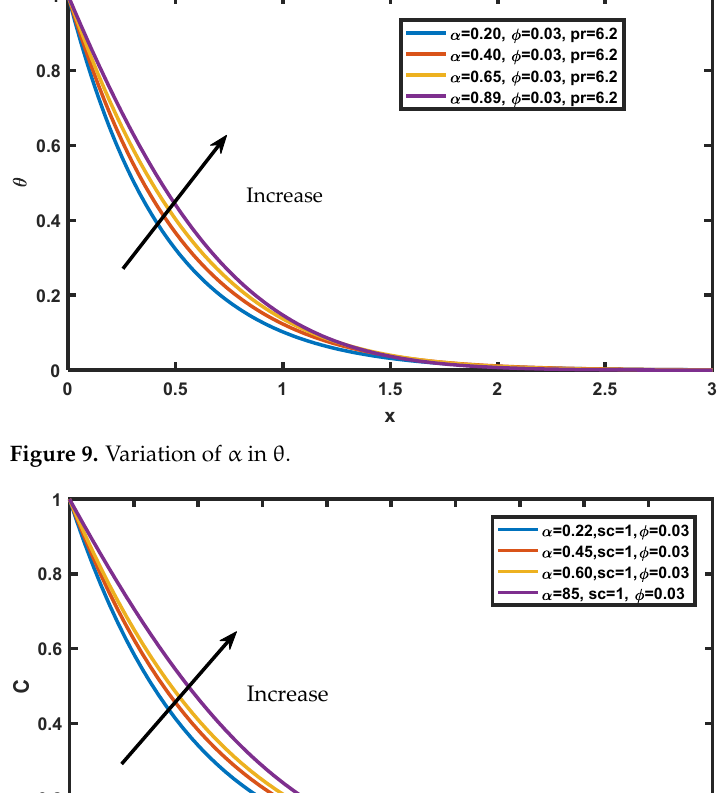
Figure 8. Variation of Pr in  .